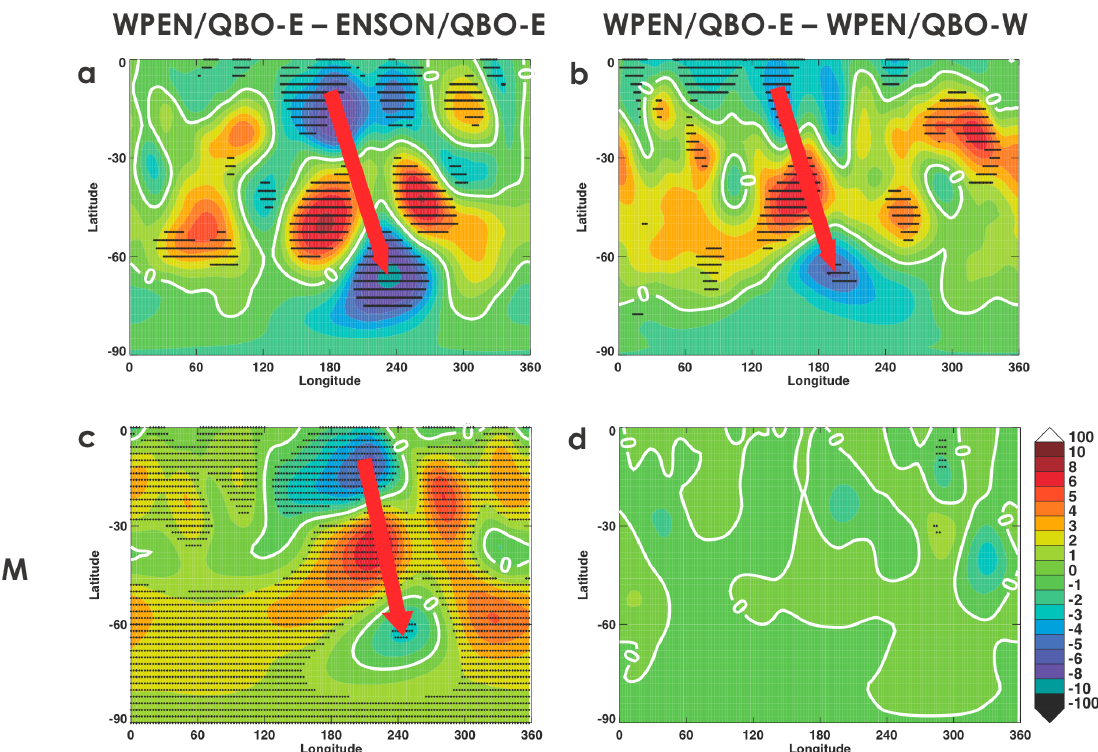
Fig. 5. Longitude-latitude contour plots showing SON seasonal mean streamfunction differences at 250hPa (10 − 6 m 3 s − 1 ) in (a, b) MERRA and (c, d) the GEOS CCM simulations. The response to WPEN events during QBO-E is shown in (a) and (c) . The response to the QBO phase during WPEN events is shown in (b) and (d) . White contours indicate zero difference. Black Xs indicate regions where differences are significant at the 90% confidence level in the MERRA reanalysis and 95% confidence level in the GEOS CCM. Red arrows indicate the approximate direction of planetary wave